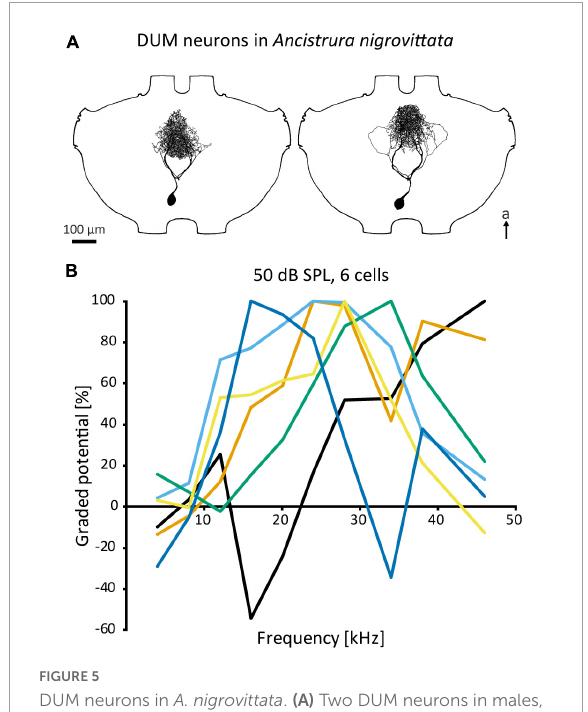
FIGURE5 DUM neurons in A. nigrovittata . (A) Two DUM neurons in males, the left one is morphologically classified as “narrow” and high frequency tuned, the right one is classified as “loops” and mid frequency tuned. (B) Iso-intensity responses of 6 out of 11 DUM-neurons recorded in one female with the relative graded responses (sum of excitation and leading inhibition normalized to the maximum response in each curve). Each cell has a different frequency tuning. a,